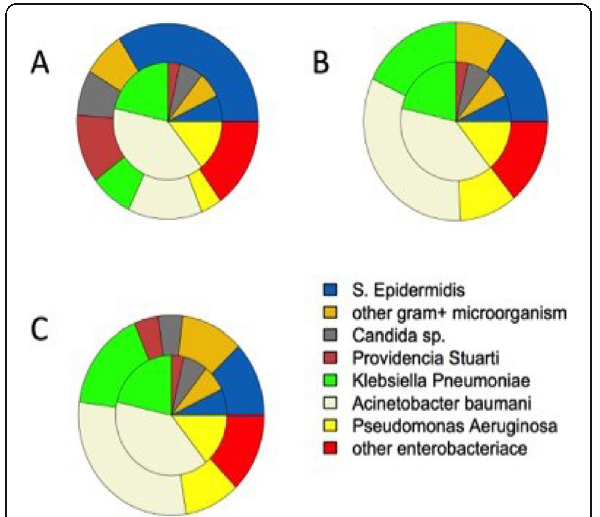
Fig. 1 (abstract 001492). See text for